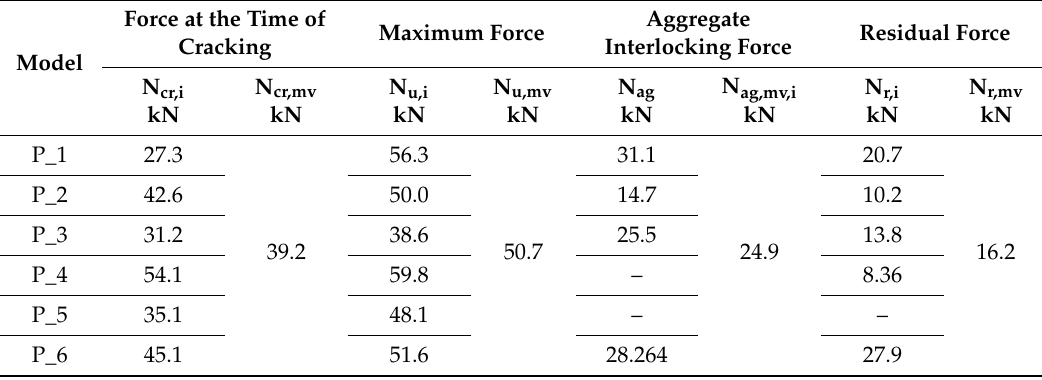
Table 2. Test results for joints between unreinforced